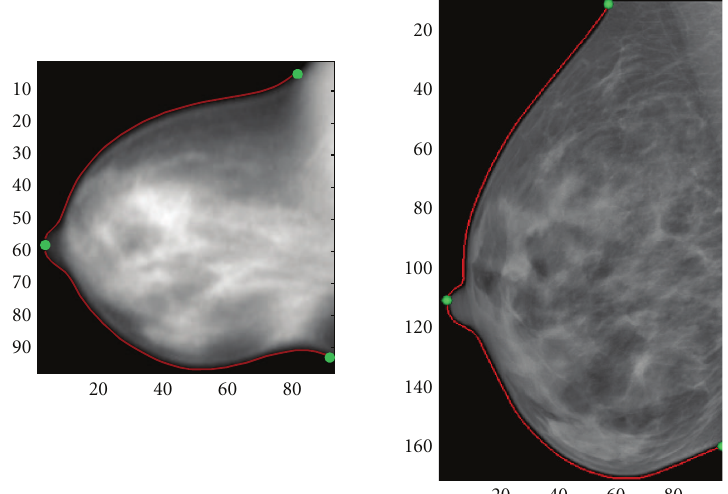
Figure 4: Preprocessed images, contour splines, and landmarks. Due to lateral expansion of tissues during compression, the mammogram (right) is approximately 30% larger than the MRPI (left).